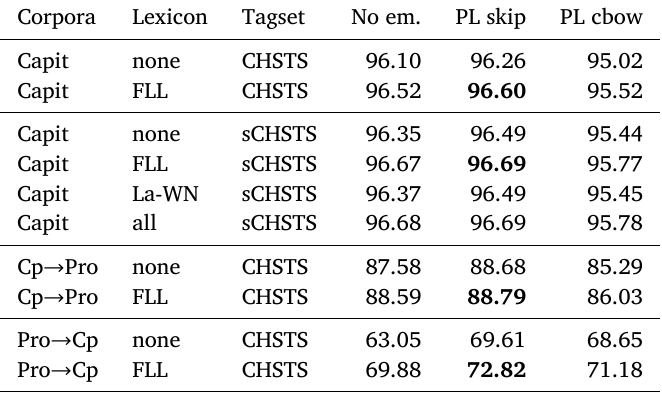
POS accuracy in %, using MarMoT, for combinations of lexicons and Mikolov-embeddings on Capitularies as well as OD-settings of Capitularies and